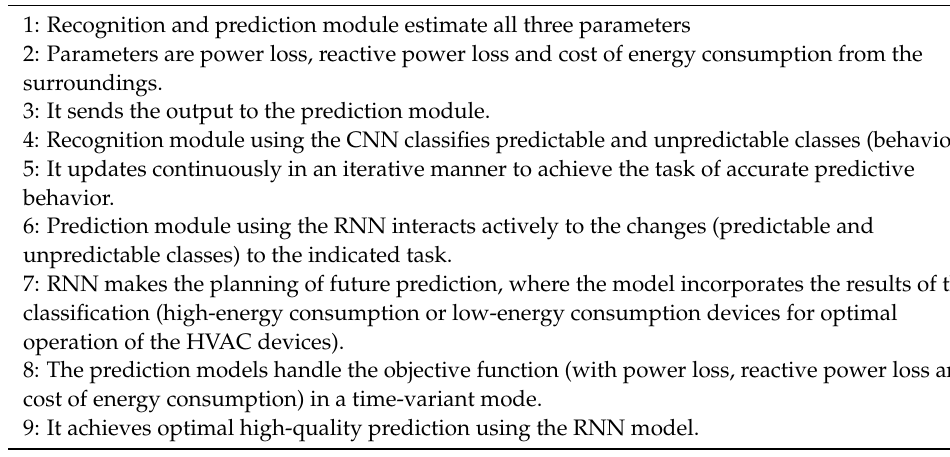
Algorithm 1: Prediction Using the